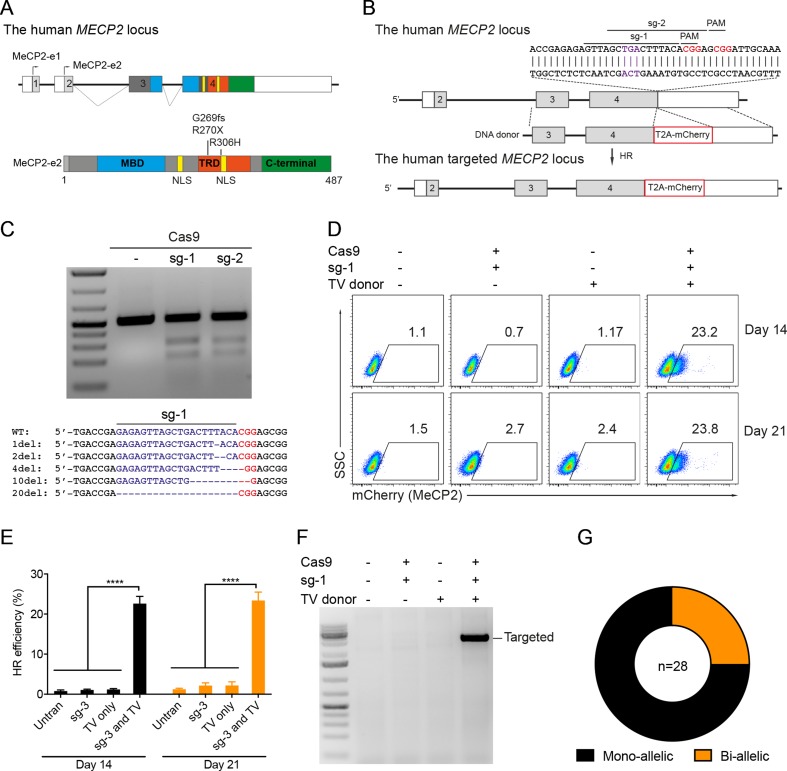
CRISPR/Cas9-mediated reporter insertion in the MECP2 locus. (A) Scheme of human MECP2 isoforms (above) and MECP2 protein with hotspot mutations in exon 4 (below). (B) Targeting strategy to insert T2A-mCherry into the MECP2 locus. (C) T7EI assay to show the editing activity of sg1 and sg2 (above) in the targeted MECP2 sequence. Sequencing data (below) indicates the INDEL spectrum of sg1 in the targeted MECP2 locus. (D) The percentage of mCherry+ cells were analyzed by flow cytometry at days 14 and 21 post-transfection. (E) The HR efficiency was summarized in the graph from three independent experiments, data show means ± SD (**** p<0.0001). (F) Corrected integration PCR. (G) Mono-allelic and bi-allelic knockin analysis in single mCherry+ cell clones. The data represent at least two independent experiments.